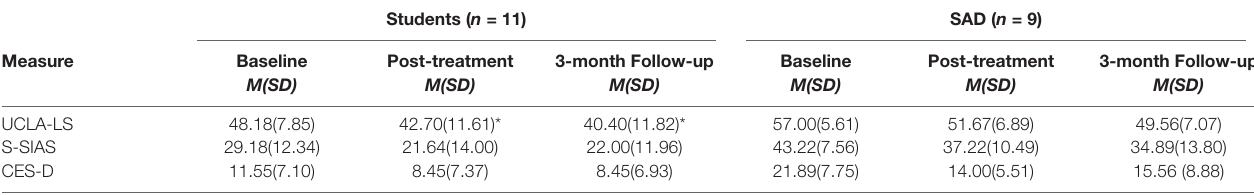
TABLE 6 | Descriptive statistics for student and SAD groups across loneliness and secondary